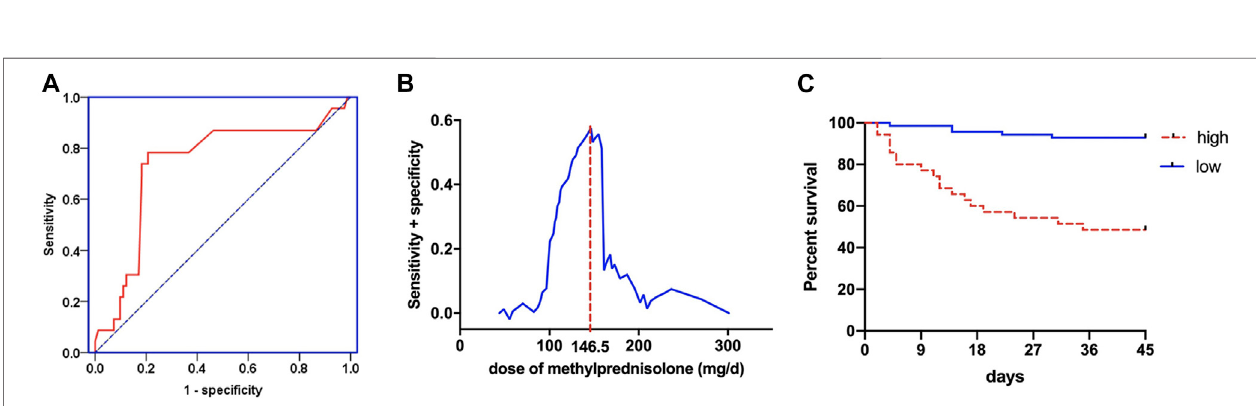
Frontiers in Pharmacology |